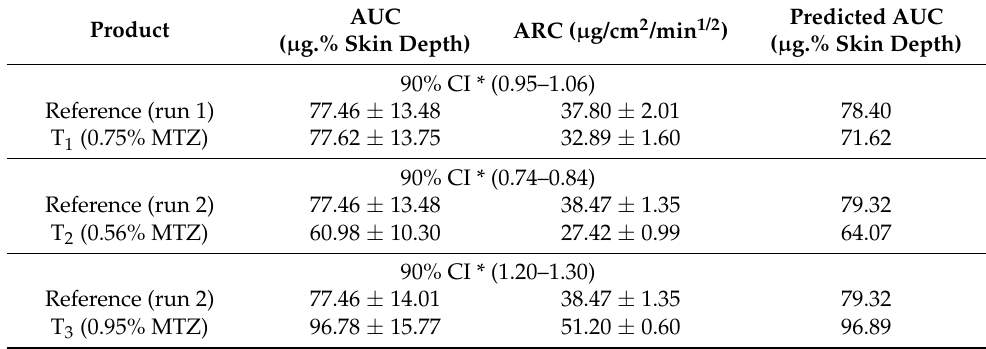
Table 1. Predicted AUC values obtained from ARC values.